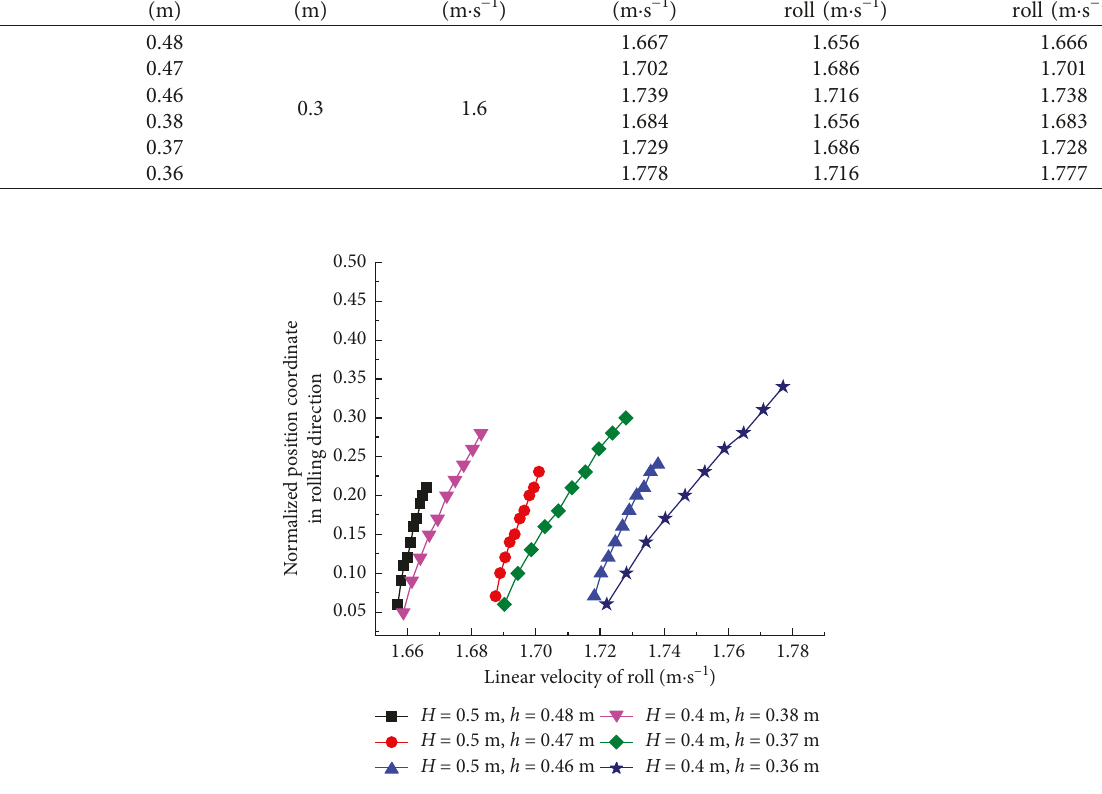
Figure 5: Locations of neutral point under different rolling